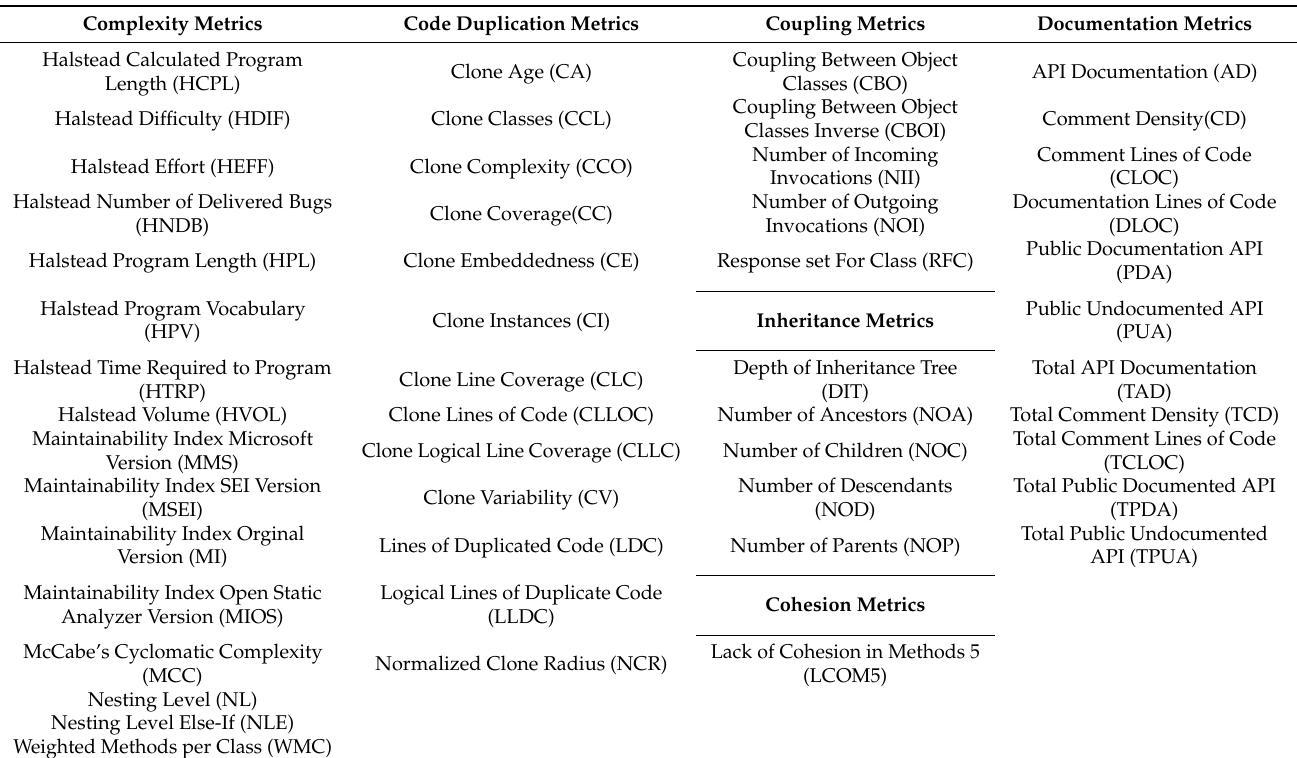
Table 2. Additional Static Metrics that were extracted using the Open Static